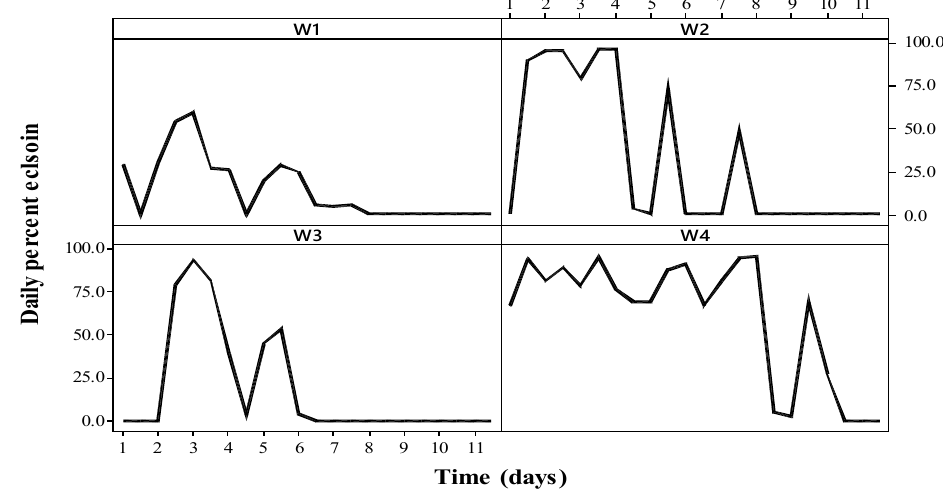
Figure 4: Daily eclosion patterns of H. isaaci females under four weight categories (W1, W2, W3 and W4). Oviposition